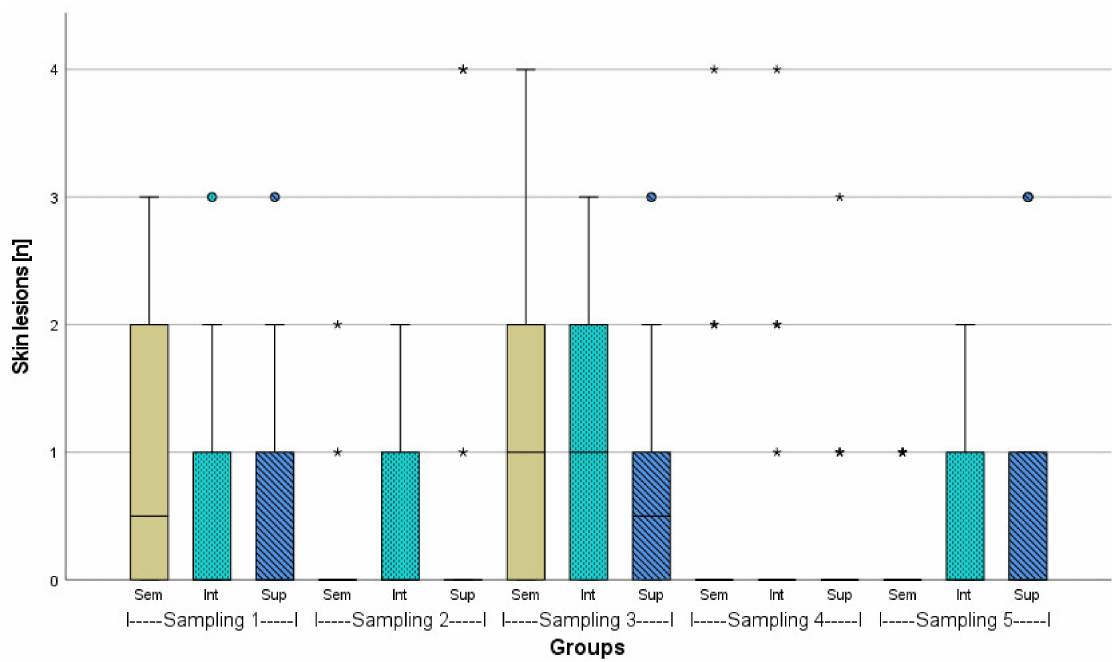
Figure 4. Number of external injuries (skin lesions) of African catfish ( n = 18) in three different stocking densities (Sem = semi-intensive, Int = intensive, Sup = super-intensive), p > 0.05. In sampling 3, in Sem, a value of 6, and in Sup a value of 8 is not illustrated. Circlets = outliers; asterisks = extreme